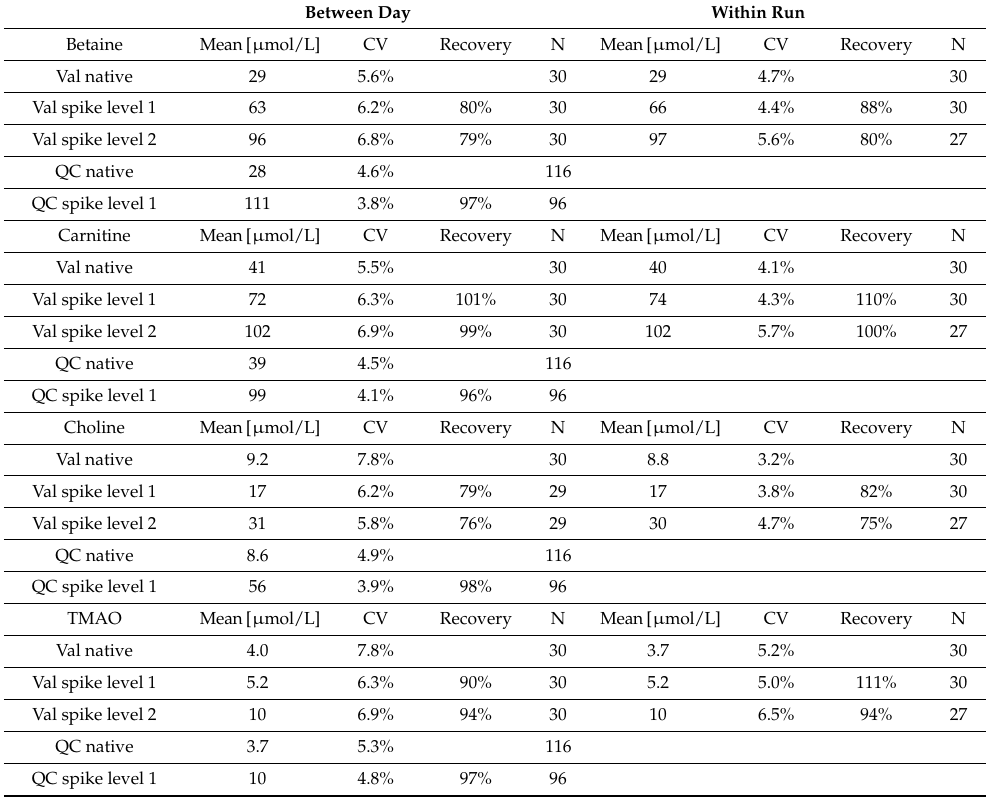
Table 2. Data on precision and recovery from validation experiments, as well as long-term quality control measurement. Shown data represents samples from validation (Val) as well as quality control